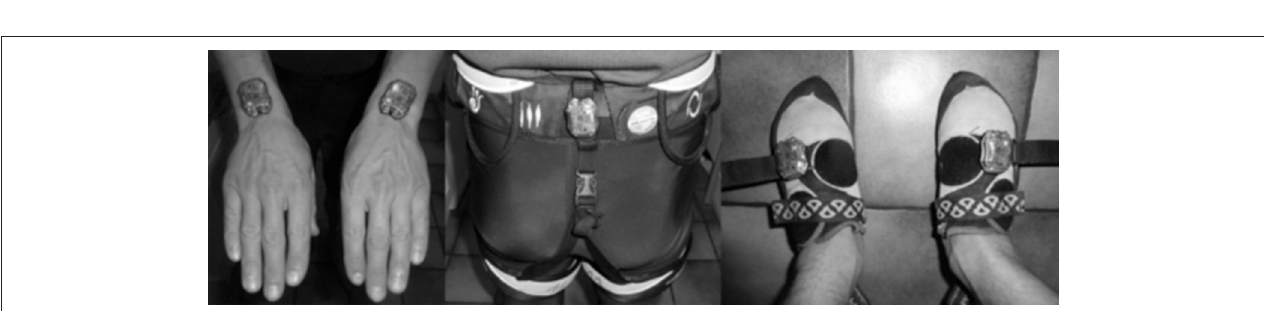
FIGURE 3 | Location of the five IMUs on the